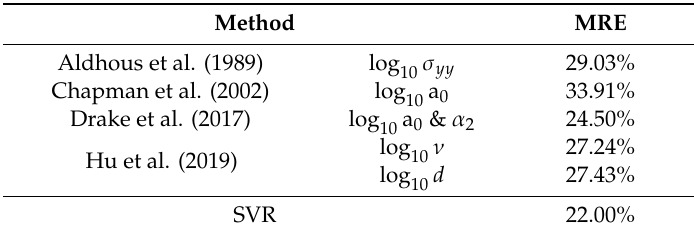
Table 4. Comparison of mean relative error (MRE) between traditional methods and SVR in estimating insect